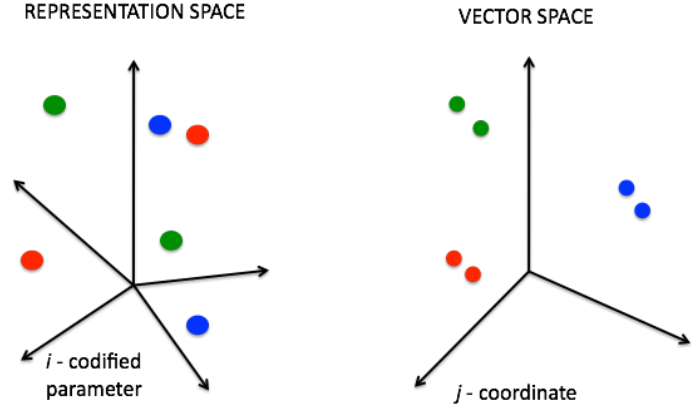
Figure A1. Input space ( left ) and target vector space ( right )